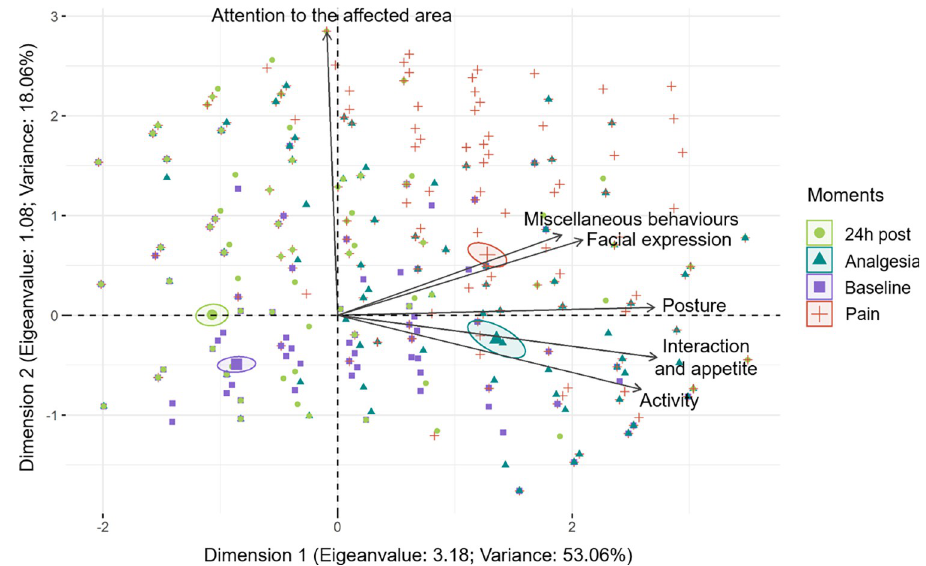
Fig 1. Biplot for the principal component analysis with time points and items of the RPBS. Ellipses were built according to perioperative time points of pain assessment. Time points: baseline —lilac, pain —red; analgesia –sea- green; 24h post —green. The ellipses referring to the time when rabbits were in severe pain ( pain ) and after rescue analgesic ( analgesia ) were positioned at the right of the graph, where the vectors of items posture, activity, interaction and appetite, facial expression, and miscellaneous behaviours are also directed. The item attention to the affected area is in a different direction to the other items. The ellipses corresponding to the baseline and 24h post time points are positioned in the opposite quadrant